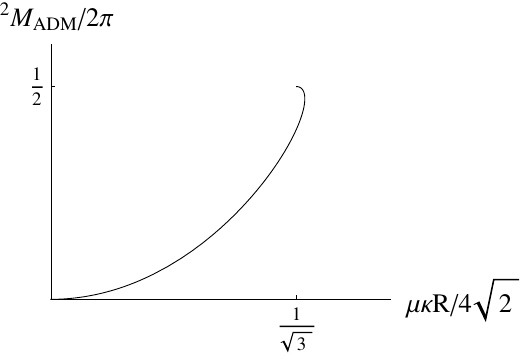
Figure 3 . Asymptotic mass-radius curve for the BPS baby Skyrmions with the old baby potential 2 squared = 4 in the asymptotically (cid:13)at (cid:25) U U